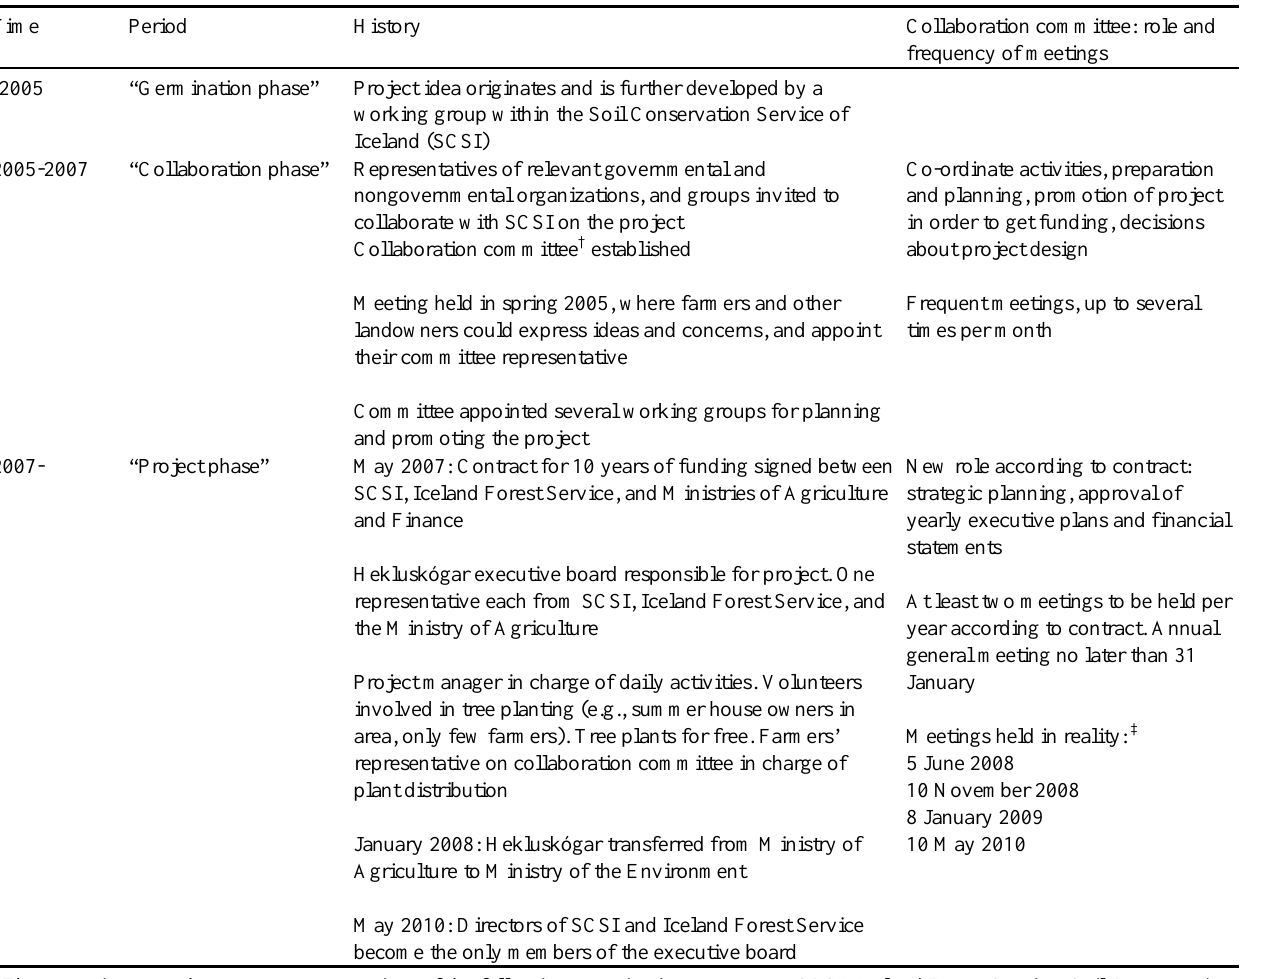
Table 2 . Hekluskógar project development and time